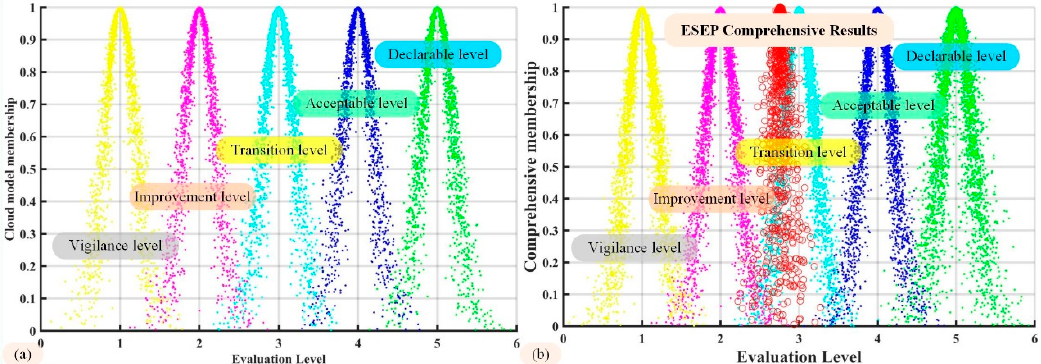
Figure 6. Evaluation cloud map of target layer and criterion layer. ( a ) Evaluation grade cloud scale; ( b ) ESEP comprehensive evaluation cloud chart.